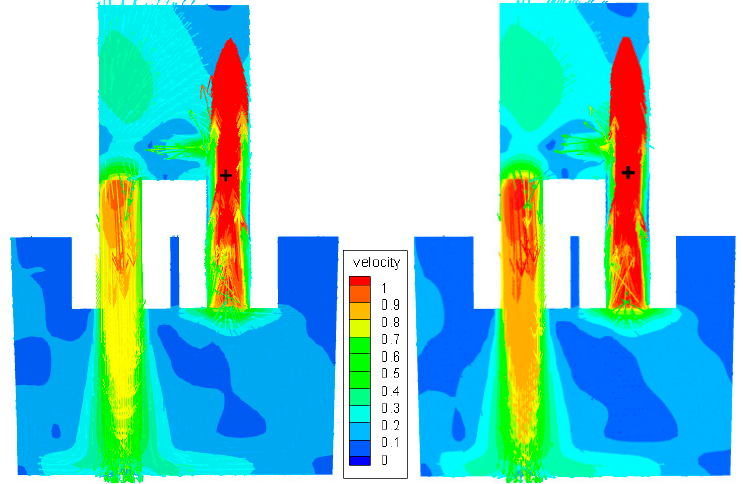
Figure 10. Velocity vector cloud chart of molten steel in RH vacuum reactor.